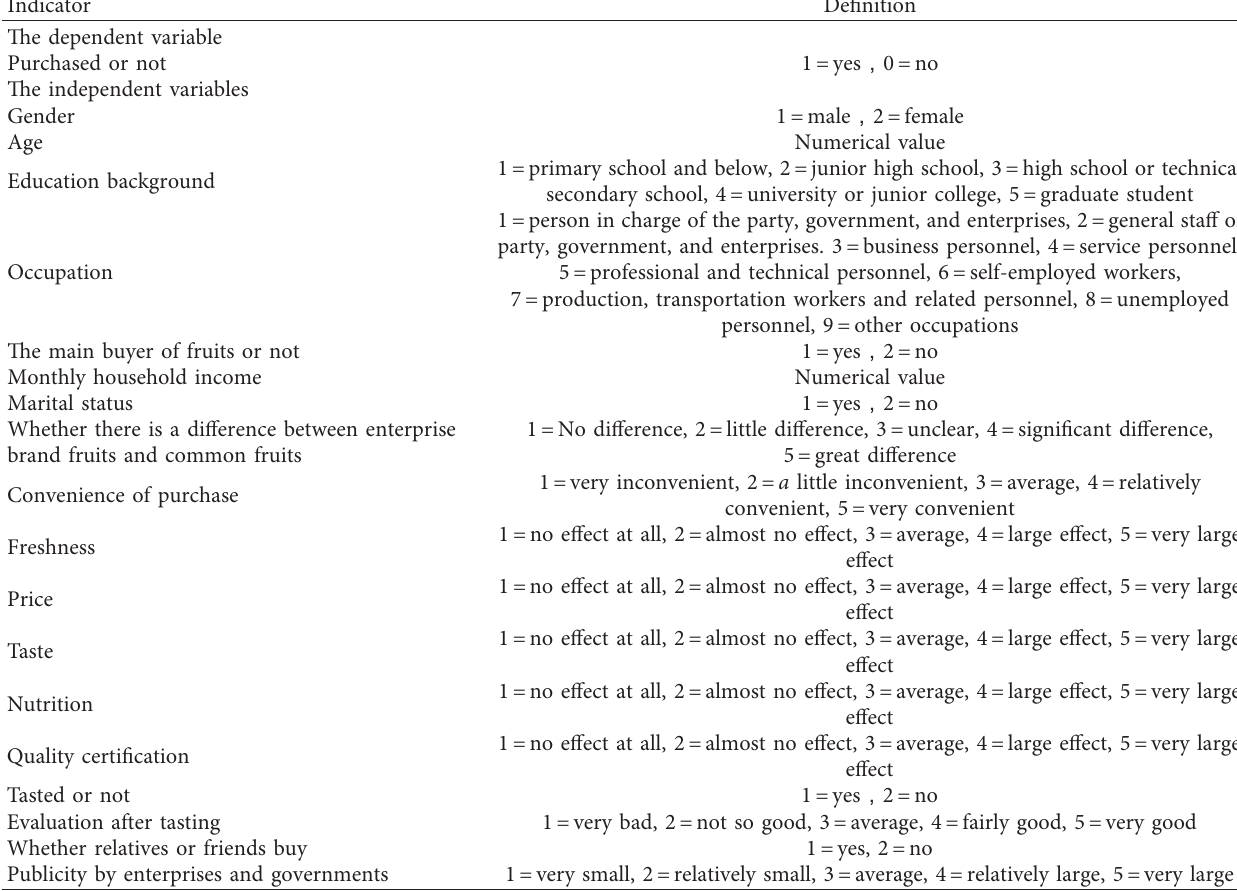
Table 1: The table of indicators’ definition.